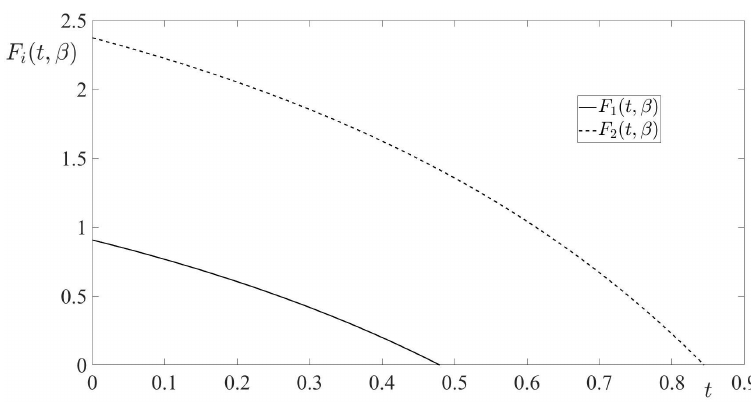
Figure 2. Functions F i ( t , β ) .